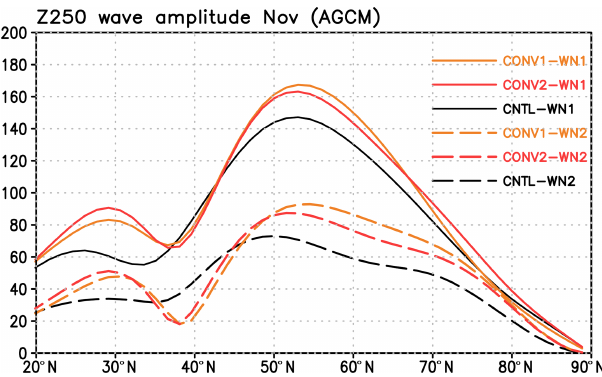
Figure 15. Latitudinal profile of the wave amplitudes at 250hPa in AGCM simulations for November based on a 60-year mean. Black lines show the control simulation, orange lines the CONV1 simu- lation and red lines the CONV2 simulation. Solid and dashed lines denote wave-1 and wave-2 components, respectively. The y axis de- notes amplitude in